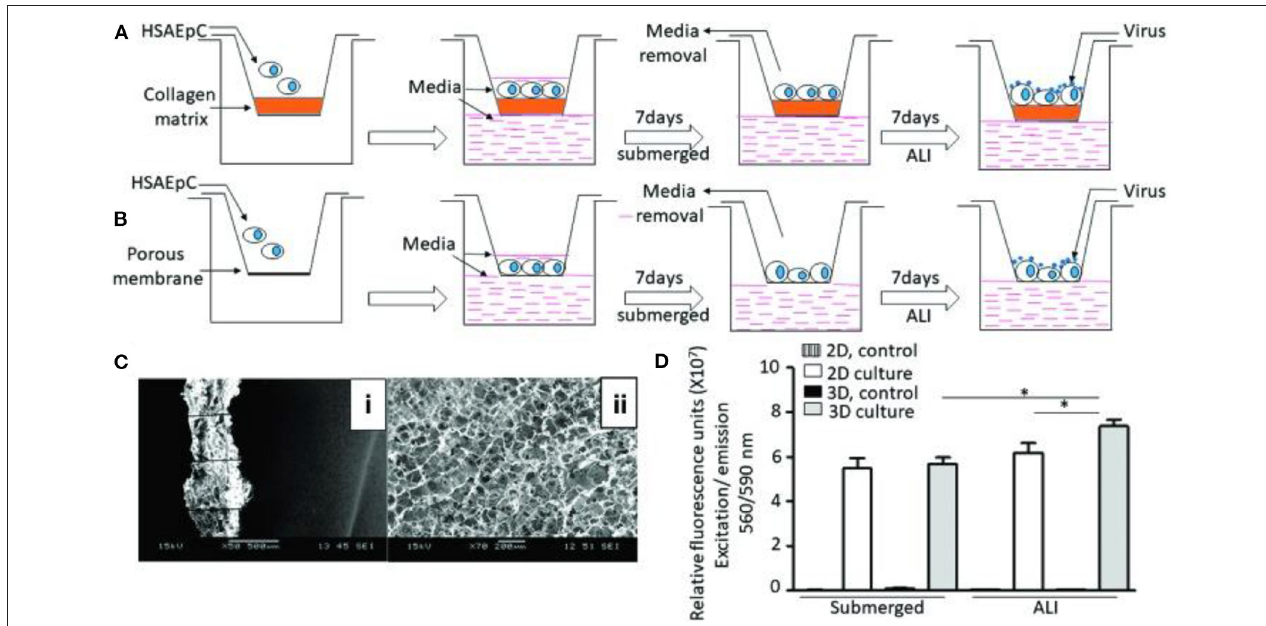
FIGURE 5 | 3D tissue engineering lung model and comparative analysis of 2D and 3D culturing of HSAEpCs (A) 3D culturing of HSAEpCs on chitosan-collagen scaffolds. (B) 2D culturing of HSAEpCs on membrane inserts. (C) SEM images showing the thickness (i) and pores (ii) of the chitosan-collagen scaffolds. (D) Cell viability of HSAEpCs from 2D and 3D culturing. This figure is reprinted under the terms of the Creative Commons Attribution License from Bhowmick et al. (2018). * indicates a significant difference was detected between